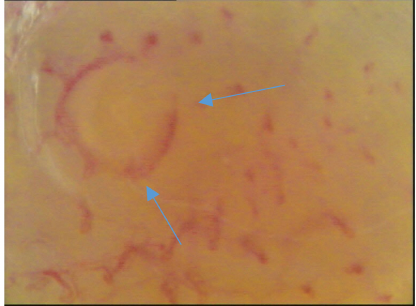
Figure 4. Capillaroscopic “sun” pattern in neuropathic diabetic foot (NDF)